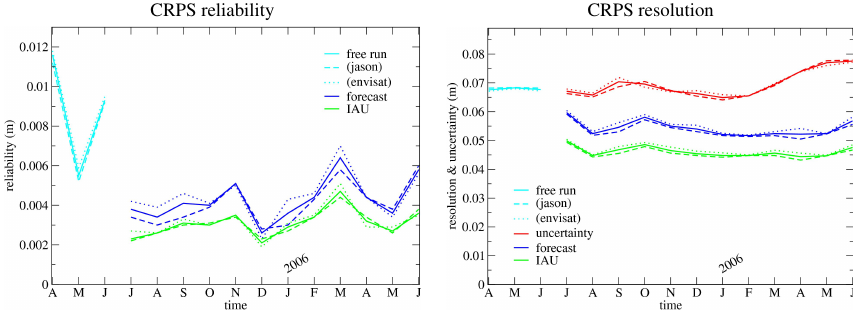
Figure 10. SSH: reliability (left panel) and resolution components of the CRPS compared to the uncertainty (right panel).